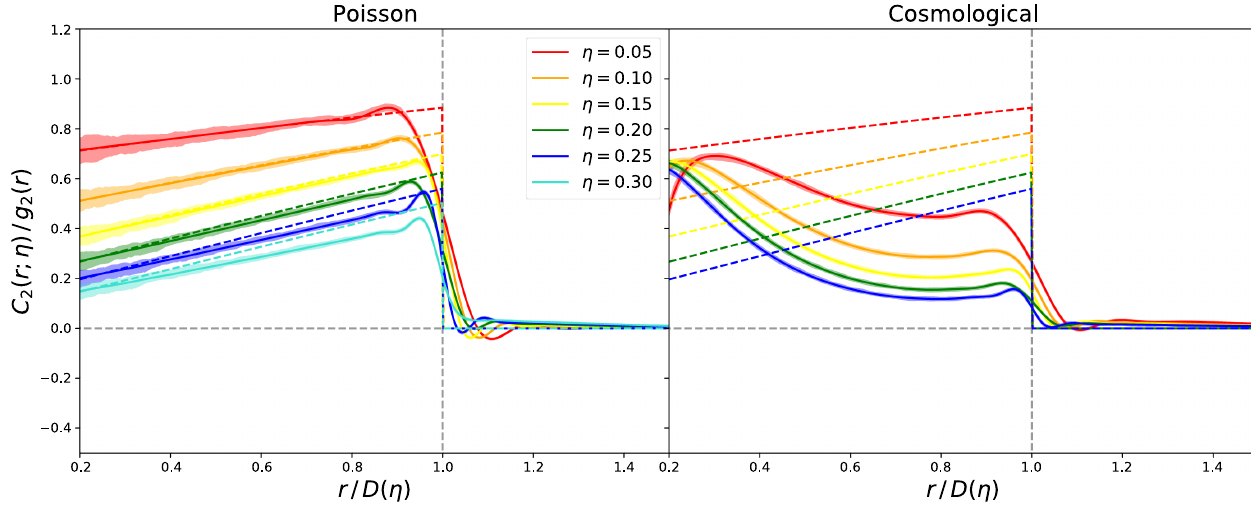
FIG. 7. Direct-connectedness function C 2 ð r; η Þ for the Poisson (left) and cosmological (right) simulations. This follows Fig. 6, but focuses on smaller scales, and additionally includes analytic predictions from the Percus-Yevick model. We additionally normalize all quantities by g 2 ð r Þ , and exclude values of η for which C 2 ð r; η Þ is not well-behaved (beyond the percolation threshold).